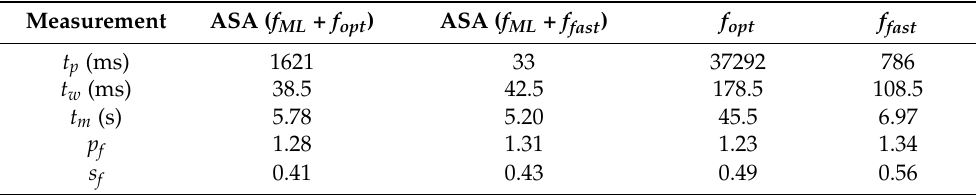
Table 1. Evaluation results—running time, path length, and